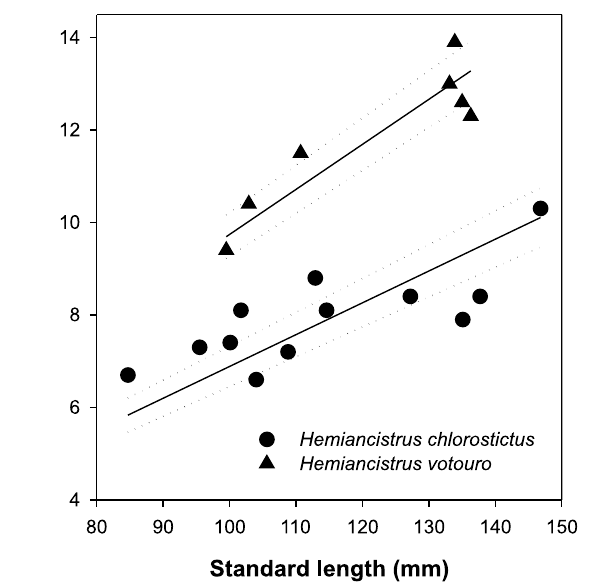
Fig. 2. Scatter plot and regression line of adipose spine length as a function of standard length in Hemiancistrus votouro and H. chlorostictus .